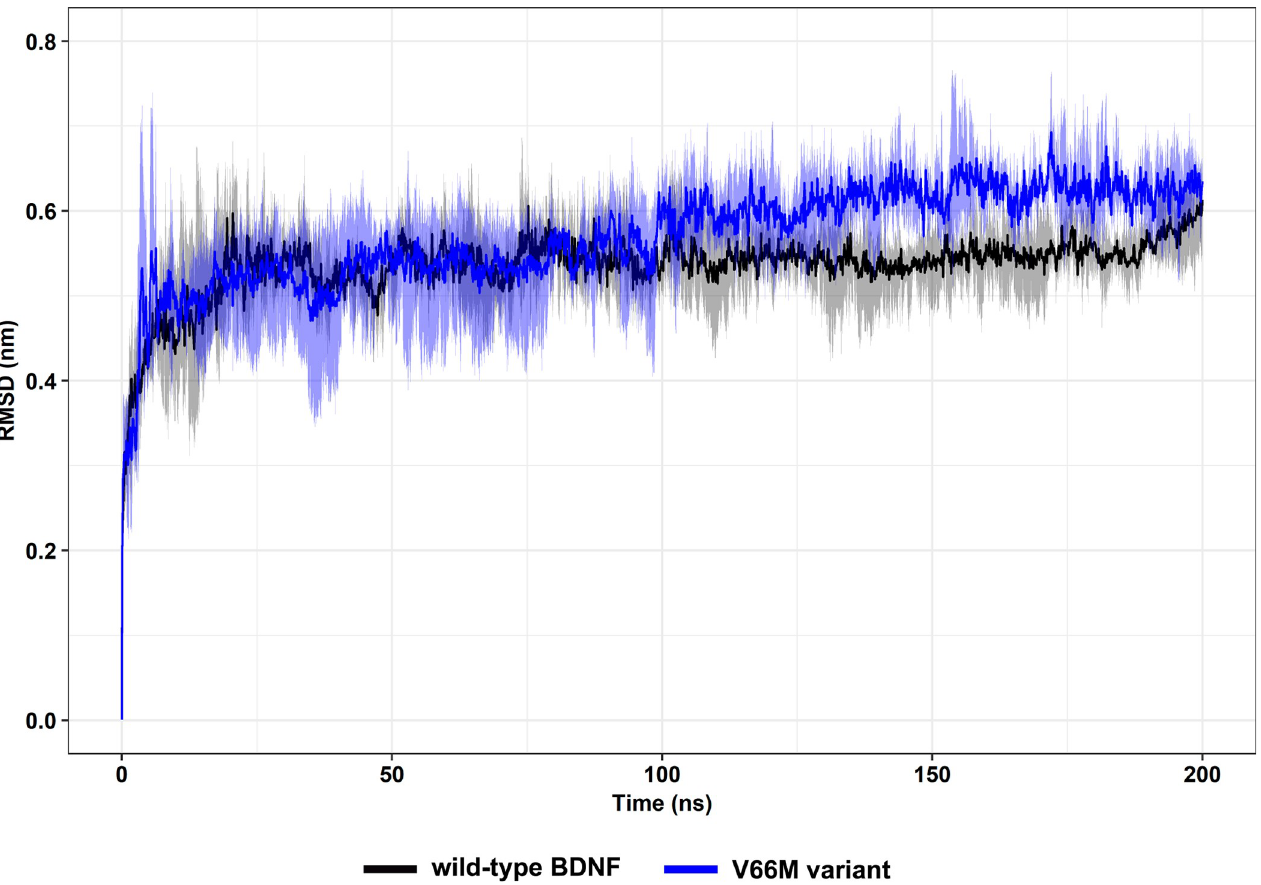
Fig 8. Backbone RMSD of wild-type BDNF and its V66M variant. RMSD of the backbone atoms of wild-type BDNF (black) and its V66M variant (blue) structures at 300 K are shown as a function of time. Mean (solid lines) and confidence interval (smooth lines) of the replicates are displayed.